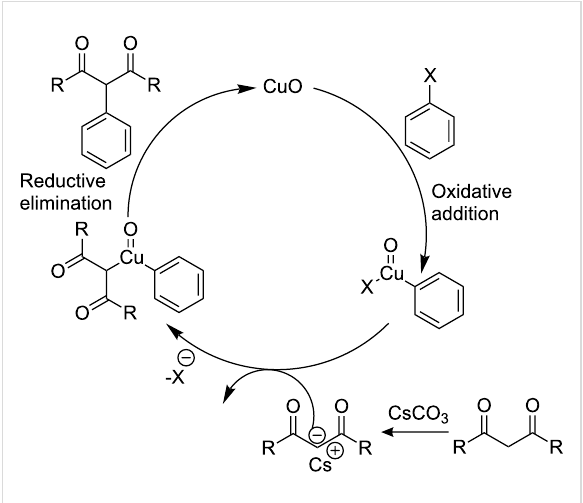
Figure 2: Proposed reaction pathway for the CuO-nanoparticles cata- lyzed C–C coupling reaction.